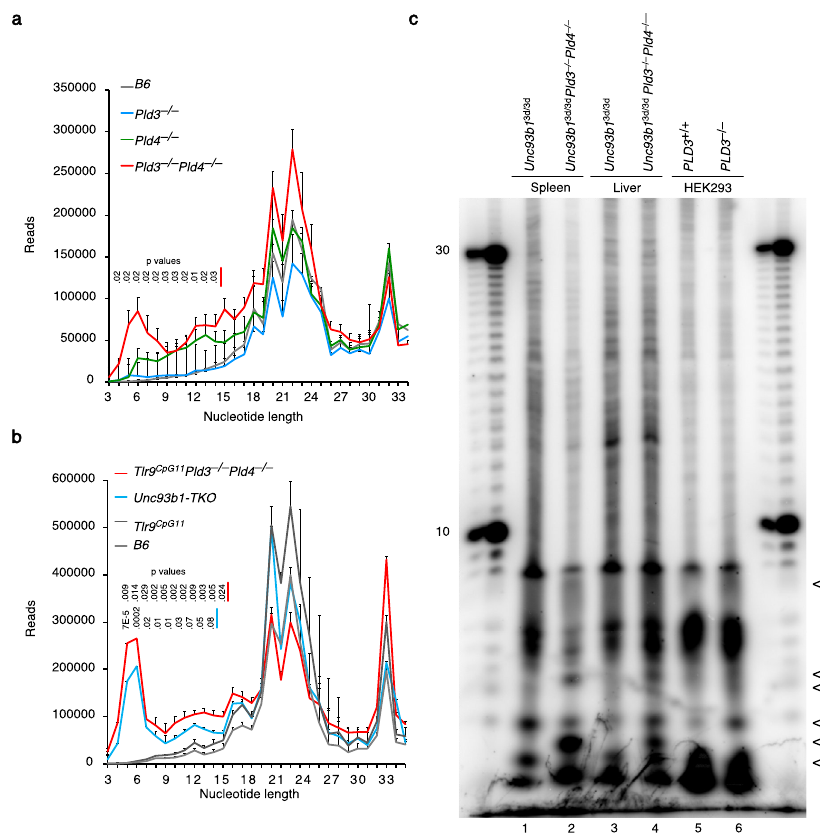
Fig. 5 Accumulation of small nucleic acids in Pld3 − / − Pld4 − / − and Unc93b1 3d/3d Pld3 − / − Pld4 − / − cells. Sequence length distributions of RNA isolated from the livers of a 2-week-old C57BL/6 (B6), Pld3 − / − , Pld4 − / − or Pld3 − / − Pld4 − / − mice, b Two-month-old B6, Tlr9 CpG11/CpG11 , Tlr9 CpG11/CpG11 Pld3 − / − Pld4 − / − or Unc93b1 3d/3d Pld3 − / − Pld4 − / − mice. Shown are means and SEM of three mice/groups. In a, p values show a signi fi cant difference in Pld3 − / − Pld4 − / − over C57BL/6 by unpaired two-tailed T -test. In ( b ), p values are shown for Tlr9 CpG11/CpG11 Pld3 − / − Pld4 − / − or Unc93b1 3d/3d Pld3 − / − Pld4 − / − sequences, compared to C57BL/6 controls. Raw data for a , b are provided in Supplementary Tables 3 and 4. c Biochemical analysis of lysosome-associated nucleic acids. Lysosomal fractions were enriched from spleen or liver tissue of Unc93b1 3d/3d Pld3 − / − Pld4 − / − or Unc93b1 3d/3d mice, or from HEK Blue-hTLR9 cells that were PLD3-suf fi cient or -de fi cient, nucleic acids were 5 ′ labeled with [ 32 P] phosphate using T4 polynucleotide kinase and electrophoresed on histidine-buffered 20% polyacrylamide gel. Radioactivity was revealed by phosphorimaging. Marker lanes show oligo dT lengths in nt. < symbol depicts the region of gel with differing abundance of nucleic acid signal. Sequence analysis shown in ( a ) and ( b ) was performed once ( n = 3 independent mice/group). Lysosomal nucleic acid analysis was performed twice with similar Ly6C expression (Fig. 7c, d). Expression of Ly6C on B and T cells is known to be driven by type I IFN and by IFN- γ 36 but because B cells from Pld4 − / − mice lacked Ly6C upregulation despite their elevated serum IFN- γ concentration, the results implicated type I IFN. When wild-type spleen cells were transferred into Unc93b1 3d/3d Pld3 − / − Pld4 − / − mice, the incoming B and